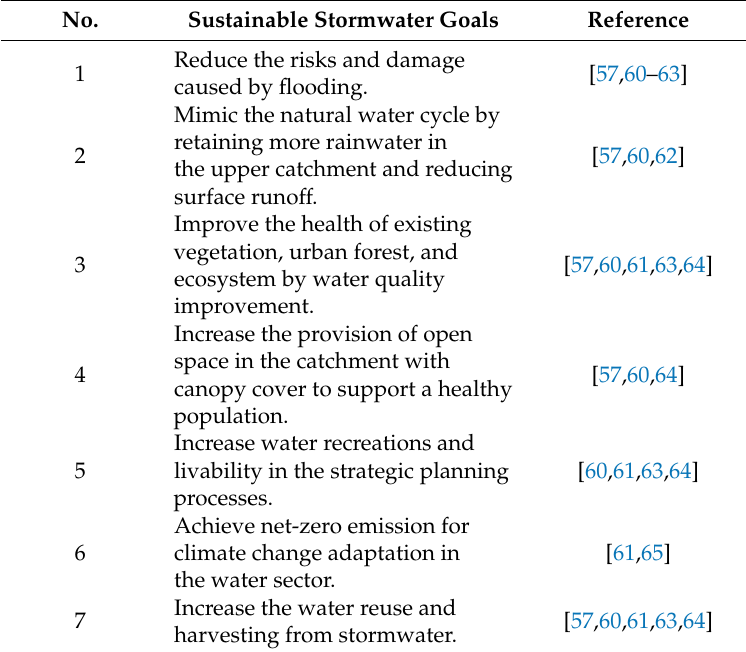
Table 2. Sustainable stormwater management goals in the study areas. No.